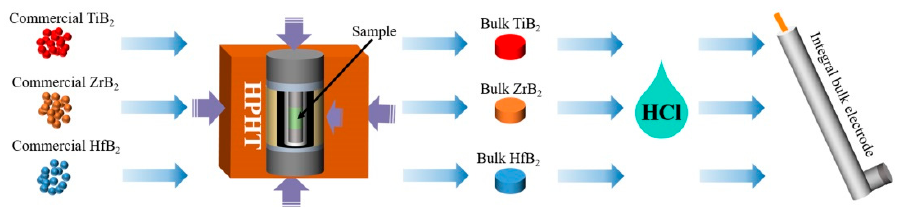
Figure 9. The experimental flow chart. (Preparation process and HER diagram of TiB 2 , ZrB 2 and HfB 2